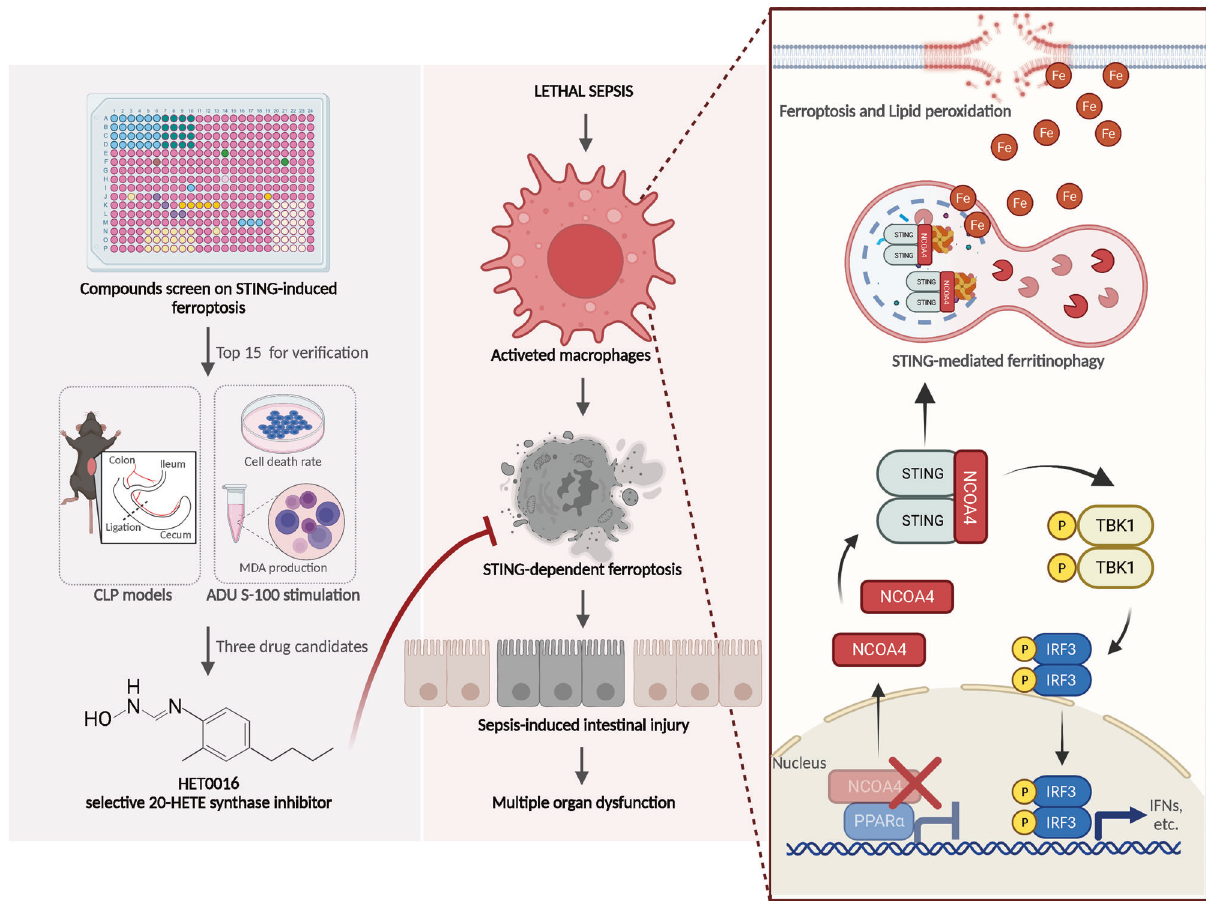
Fig. 7 The hypothetical model for STING-regulated macrophage ferroptosis promotes sepsis-induced intestinal injury via its interaction with NCOA4. In sepsis, STING can trigger ferroptosis through direct interaction with NCOA4 to induce ferritinophagy. Mechanistically, the CBD of STING directly binds the CC domain of NCOA4, which further enhances the stability of the STING dimer and lessens the protective effects of NCOA4 as a nuclear coactivator, decreasing the nuclear localization of NCOA4. These lead to macrophage ferroptosis and further